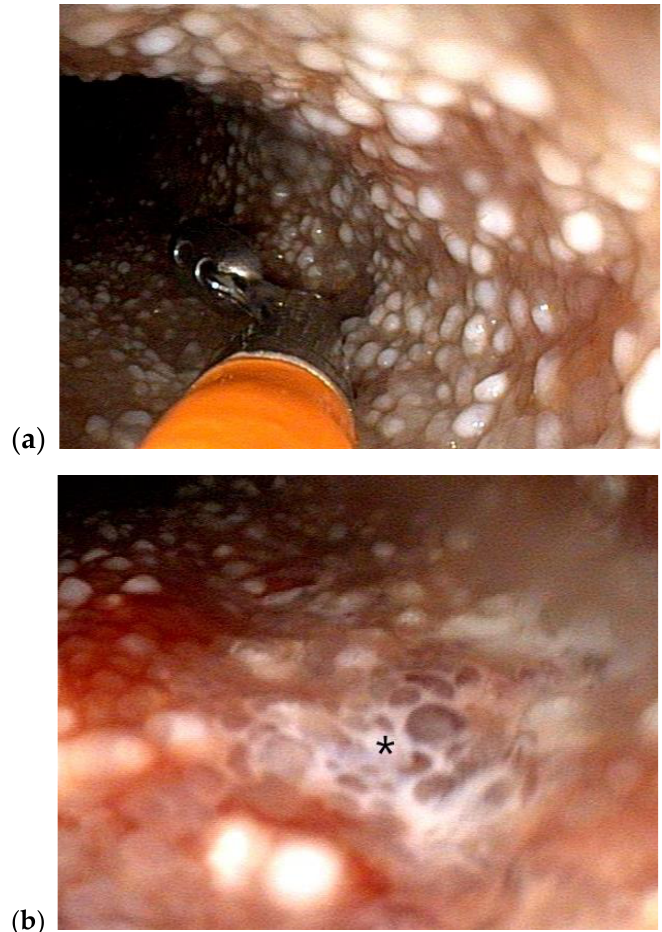
Figure 4. Duodenoscopy of a 5-year-old female, spayed soft-coated wheaten terrier with histologically diagnosed intestinal lymphangiectasia and the clinical syndrome of PLE ( a ) Multiple pinpoint to coalescing “white spots” consistent with dilated intestinal lymphatics are grossly visible during endoscopic exam and biopsy ( b ) leakage of lymph (shown with asterisk) is apparent on the mucosal surface of the small intestine.